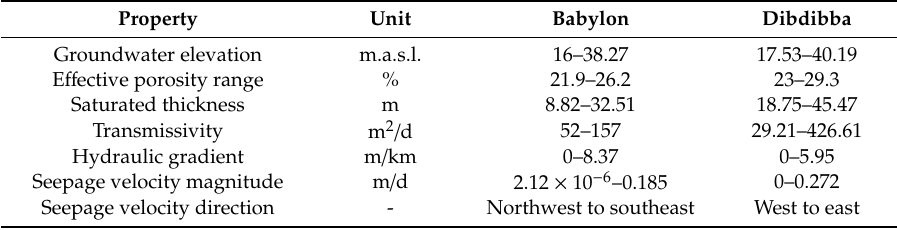
Table 2. Comparison of the geo-hydrological properties between Babylon and